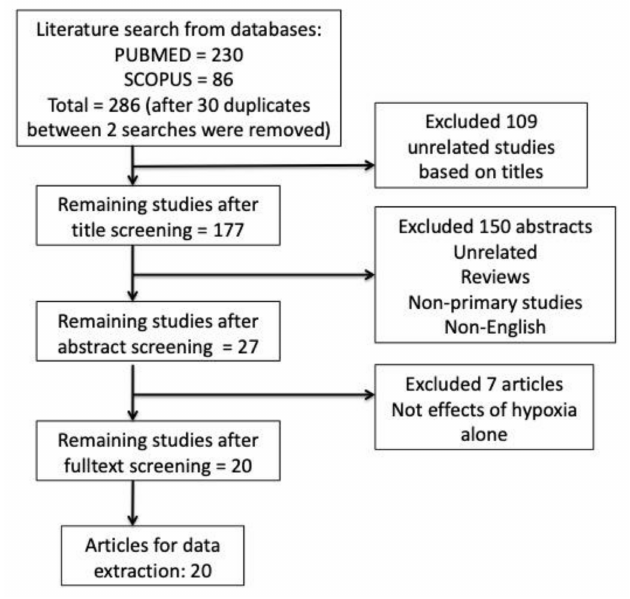
Figure 1. Flowchart of the article selection strategies for this systematic